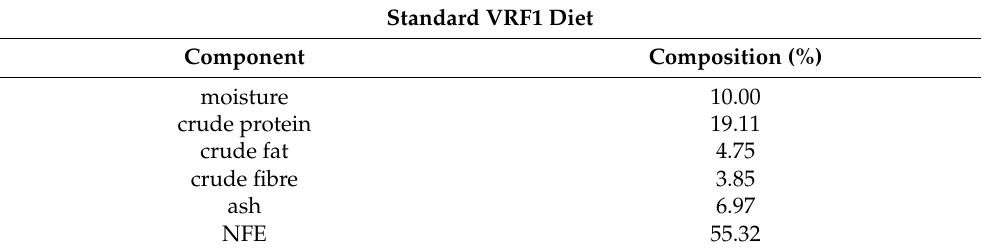
Table 1. Components of the standard VRF1 diet.